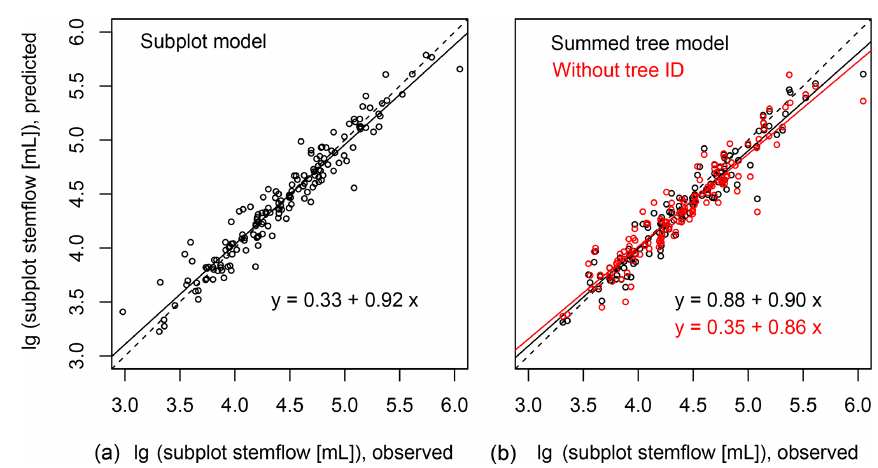
Figure 8. (a) Predicted stemflow per subplot using the subplot linear mixed effects model in relation to observed values for the large event class. (b) Stemflow sums per subplot predicted by the individual tree linear mixed effects model in relation to observed values. Panel (b) additionally shows the predicted values when excluding the tree ID random effect from the individual tree model. Dashed lines give the one-to-one line, continuous lines show the linear regressions and equations are given in the